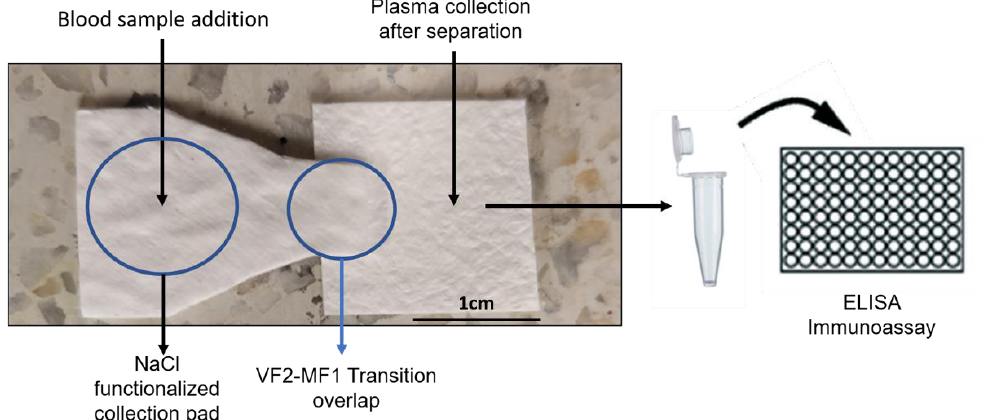
Figure 2. Fabricated BPS device. The sample is added to the center of the NaCl-functionalized VF2 collection pad and wicks towards the MF1 plasma reservoir for S100B detection on the ELISA immunoassay.